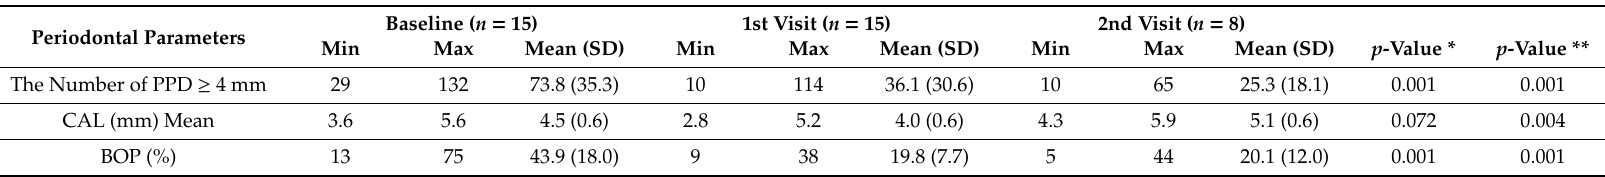
Table 2. E ff ects of periodontal treatment; anti-infective treatment / scaling and root planing (SRP) in 15 adult patients with periodontitis to the clinical parameters